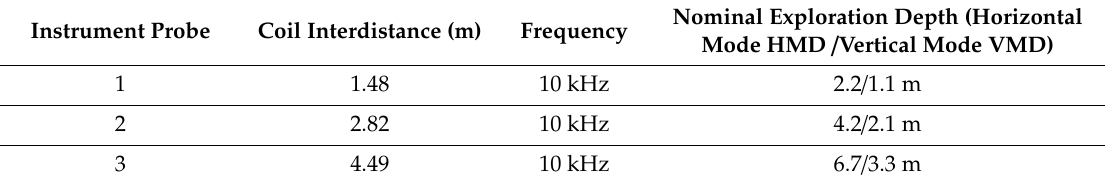
Table 1. Technical specifications of the multicoil CMD Explorer